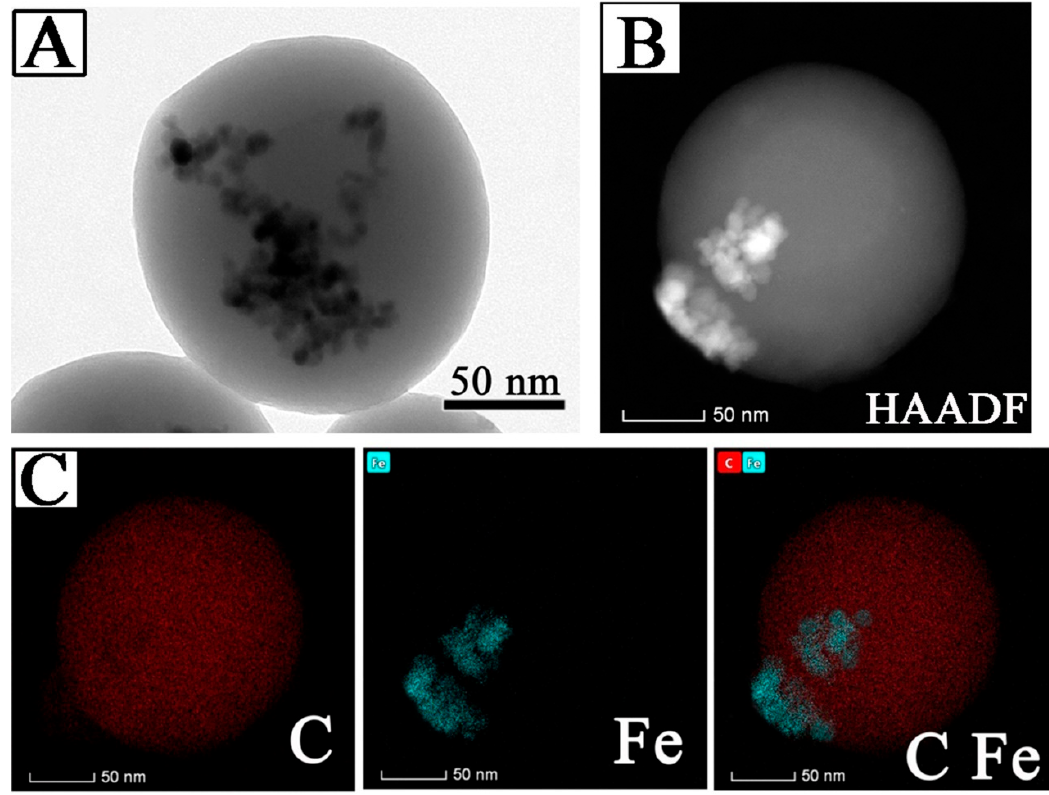
Figure 5. ( A ) HRTEM image of individual Fe 3 O 4 @LNPs; ( B ) High-angle annular dark field image (HAADF) and ( C ) element mapping analysis of Fe 3 O 4 @LNPs.